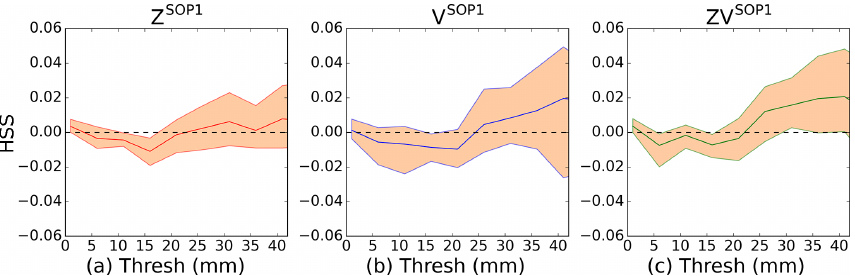
Figure 12. Differences in the average Heidke skill score (HSS) of the 6h cumulated precipitation forecasts versus rain gauge measurements, between the three RASTA experiments and the CTRL SOP1 experiment (a) Z SOP1 , (b) V SOP1 and (c) ZV SOP1 . Calculations were performed over the 32 runs in which RASTA data were assimilated. The error bars represent the 95% bias-corrected and accelerated (BCa) bootstrap confidence intervals (see Efron and Tibshirani,